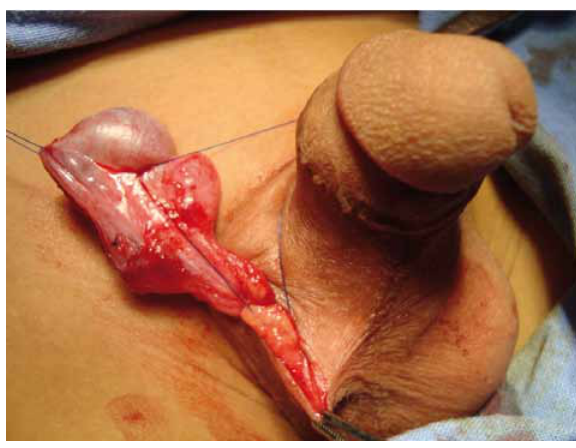
Figure 1a - The testis mobilized and delivered through the incision.